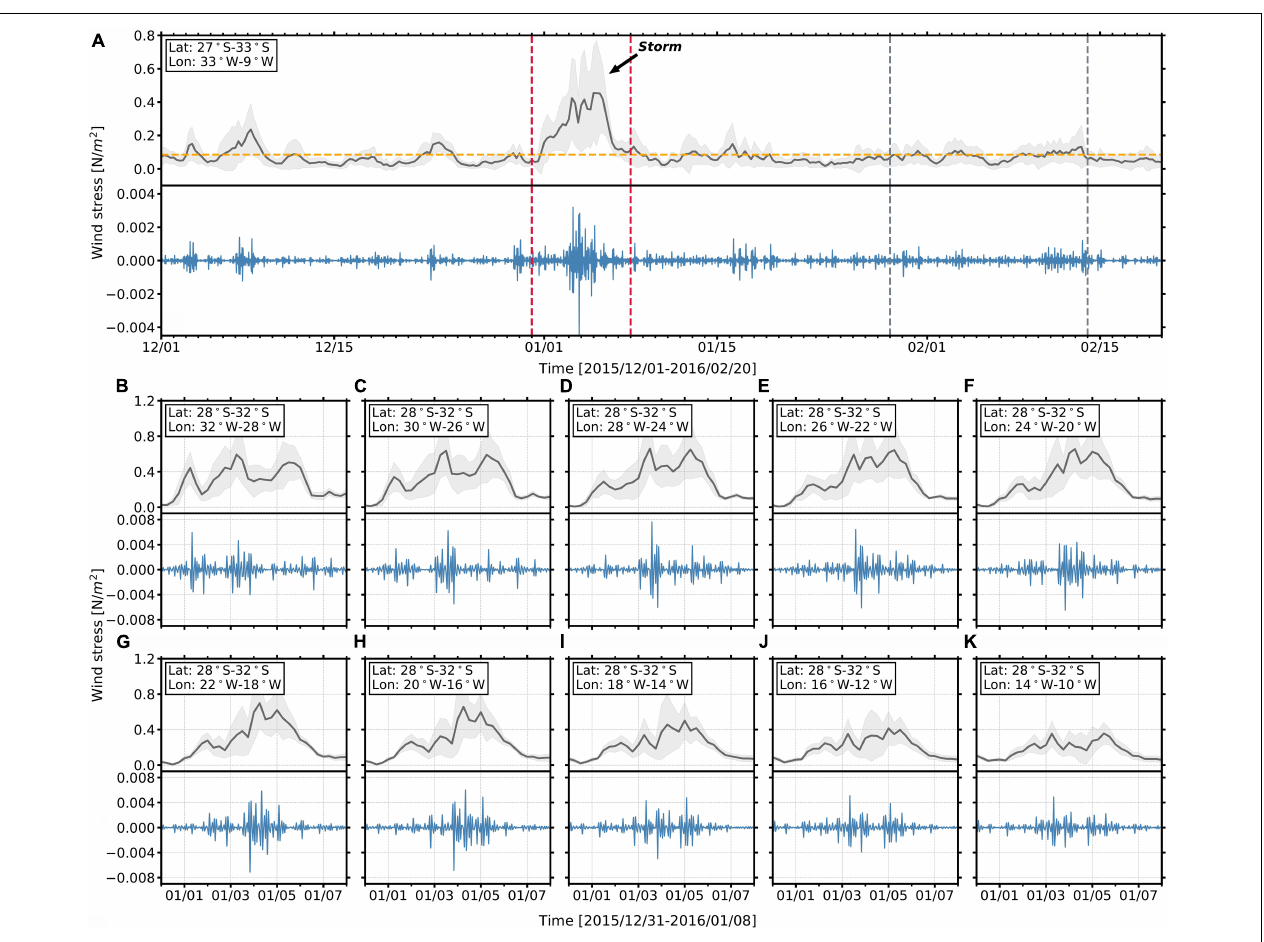
FIGURE 8 | Wind stress variability in time and space. (A) Spatially averaged wind stress as a function of time for region 33 ◦ W, 9 ◦ W, 27 ◦ S, 33 ◦ S (upper panel) and its corresponding bandpass filtered near-inertial wind stress (lower panel). Black line = averaged wind stress; blue line = near-inertial wind stress; horizontal dash yellow line = average wind stress for the entire time period. Light gray shade represents the standard deviation of measurements. Vertical red dashed lines bound the time of high wind stress that are analyzed individually as a function of space from panels (B–K) . Vertical gray dashed lines bound the days of the seismic survey. (B–K) Same as (A) but for averaged wind stress during the storm analyzed in a series of spatially overlapping windows described in the text. The region of each window is shown in the box at the upper right corner of each figure. The black arrow points to the feature that we interpreted as a storm because its wind stress is greater than eight standard deviations from the mean. Wind stress are calculated from wind speed data from NCEP reanalysis 2 (Kanamitsu et al.,